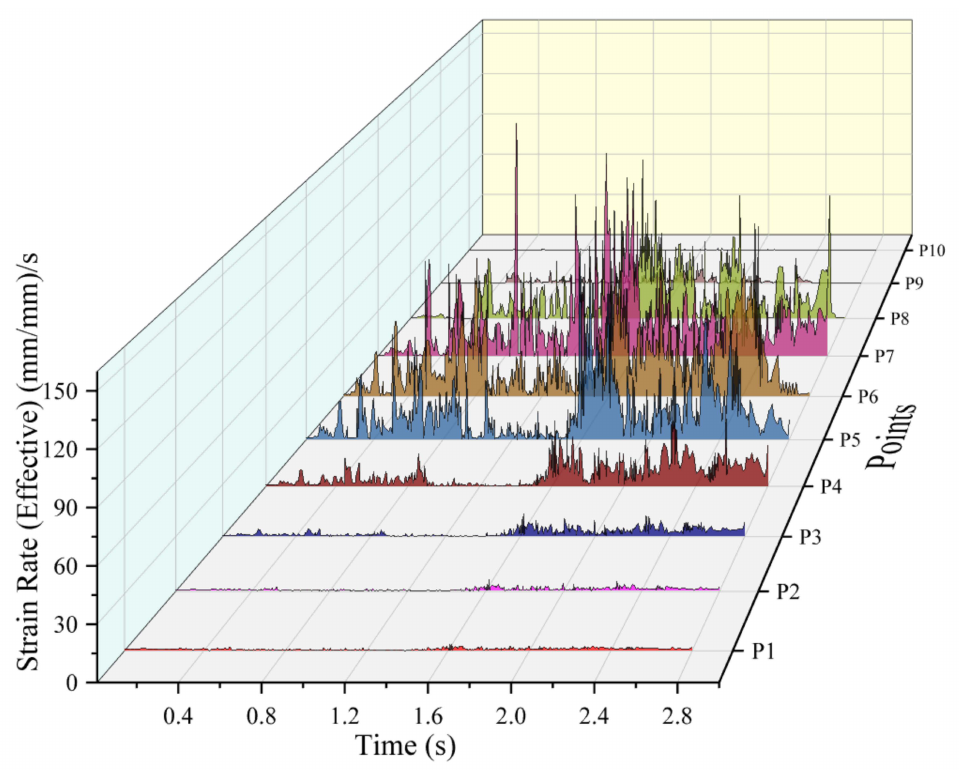
Figure 15. Strain rate at the point locations (P1–P10), located on top of the workpiece, see Figure 11.